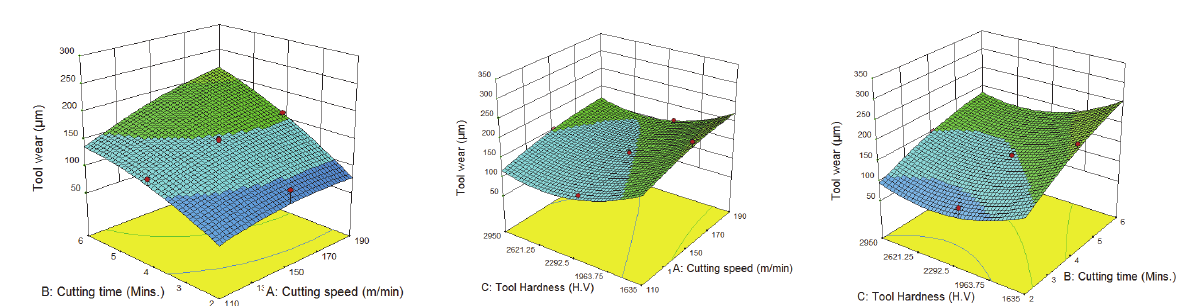
Fig. 3 . Effect of cutting speed and cutting time on tool wear